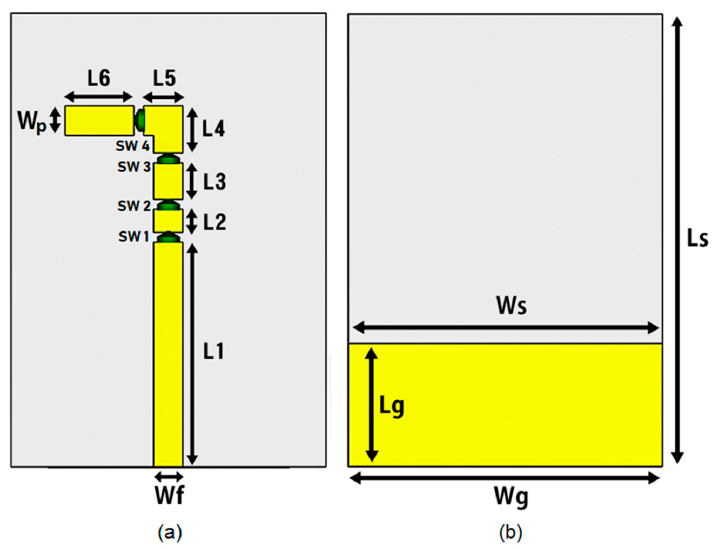
Figure 1. The geometry of proposed antenna: ( a ) Front view ( b ) Rear view. Table 1. Dimensions of proposed antenna.